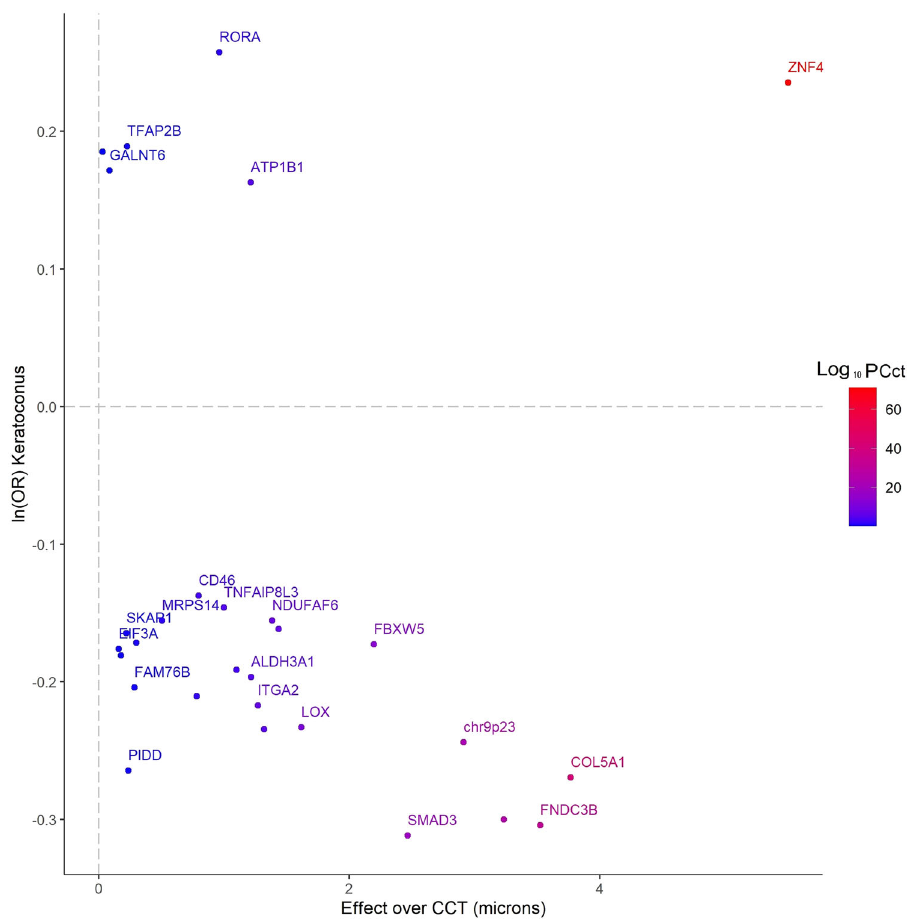
Fig. 4 Comparison of the same SNP allele effect sizes over central corneal thickness (CCT; in microns, the x-axis). Data reported by Choquet et al. 20 (also in Supplementary Data 14), with those over keratoconus (4669 cases and 116,547 controls, natural logarithm of the ORs, the y -axis). The alleles increasing susceptibility to keratoconus were selected as reference alleles. The genes located nearest to the most signi fi cant SNPs are shown in the labels and their color-codes denote the signi fi cance ( − log10( p -value) of the association with CCT 20 . For the sake of clarity, only some of the genes are labeled. Unlabeled points denote SNPs in intragenic regions (distance from the nearest known protein-coding transcript greater than 250kbp). The variants are annotated to the nearest known protein-coding transcript. Because of their proximity with other SNPs, some loci in this fi gure are not labeled. Polymorphisms identi fi ed in the discovery cohort, but not shown in this fi gure were not available for analysis in the replication